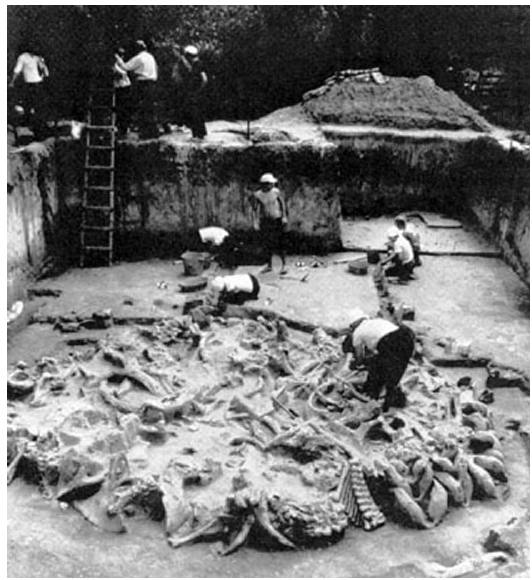
Figure 4. Mezhyrich Dwelling 4 [30]. Photo: courtesy Olga